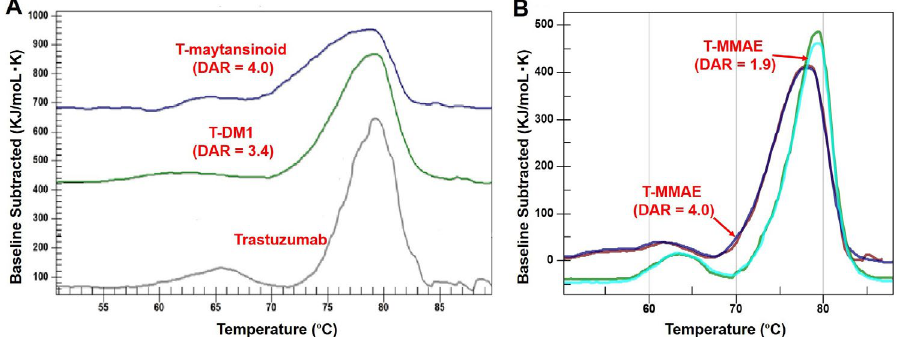
Figure 2. Comparison of DSC thermograms. A. Trastuzumab, T-DM1 and trastuzumab-MCC-maytansinoid (T-maytansinoid); B. trastuzumab-MC-VC-PAB-MMAE (T-MMAE) with DAR = 1.9 and Trastuzumab-MC-VC-PAB-MMAE (T-MMAE) with DAR =